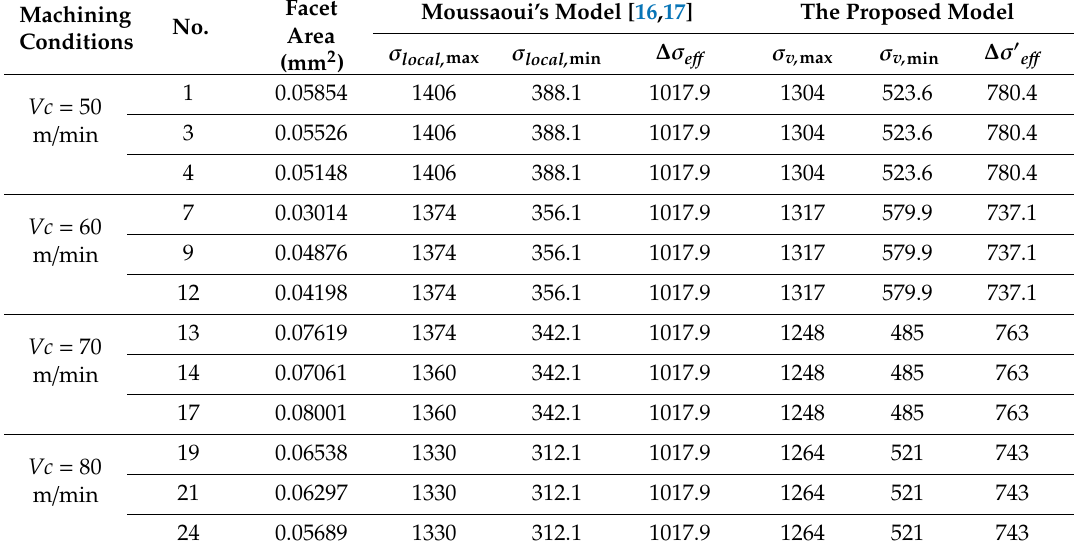
Table 5. The facet area of specimen fracture surfaces under different machining conditions.